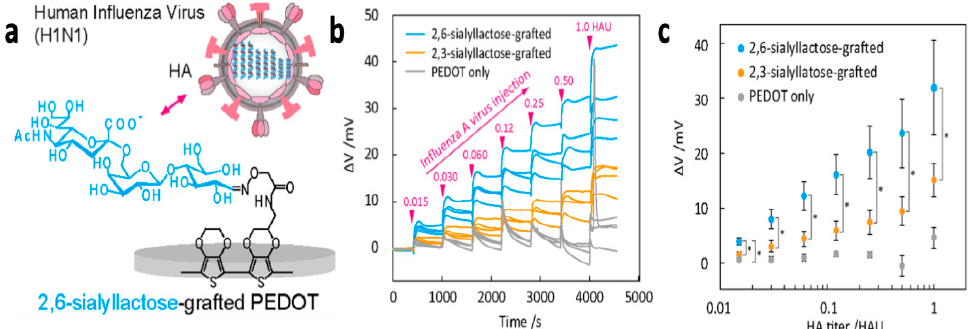
Figure 24. ( a ) Design of siallyllactose-based PEDOT sensor for detection of H1N1 virus. ( b ) Potential changes as a function of time upon the sequential addition of H1N1 virus solutions of varying concentrations to PEDOT-only (control) or siallyllactose-granfted PEDOT. HAU—hemagglutinin units. ( c ) Potential changes as a function of H1N1 virus concentration. * p < 0.05 [119]. Reprinted with permission from ACS Applied Materials and Interfaces , “Specific Recognition of Human Influenza Virus with PEDOT Bearing Sialic Acid-Terminated Trisaccharides,” W. Hai, T. Goda, H. Takeuchi, S. Yamaoka, Y. Horiguchi, A. Matsumoto and Y. Miyahara, Vol. 9, pp. 14162–14170, Copyright 2017 with permission from the American Chemical Society.